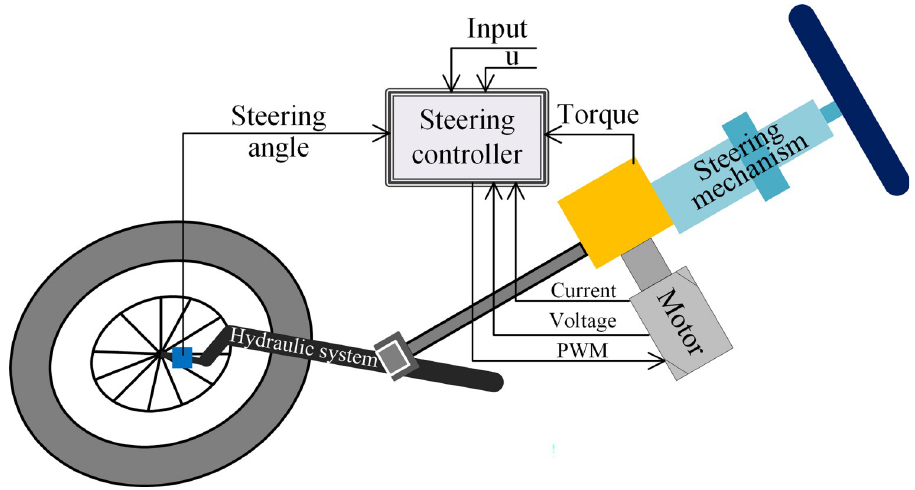
Fig 4. Steering system model